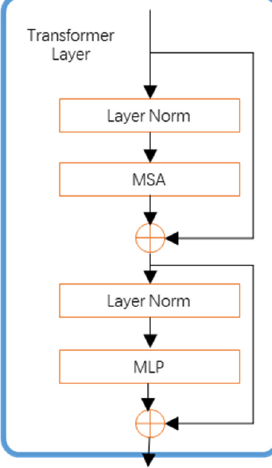
Figure 3. Feature extraction transformer part.